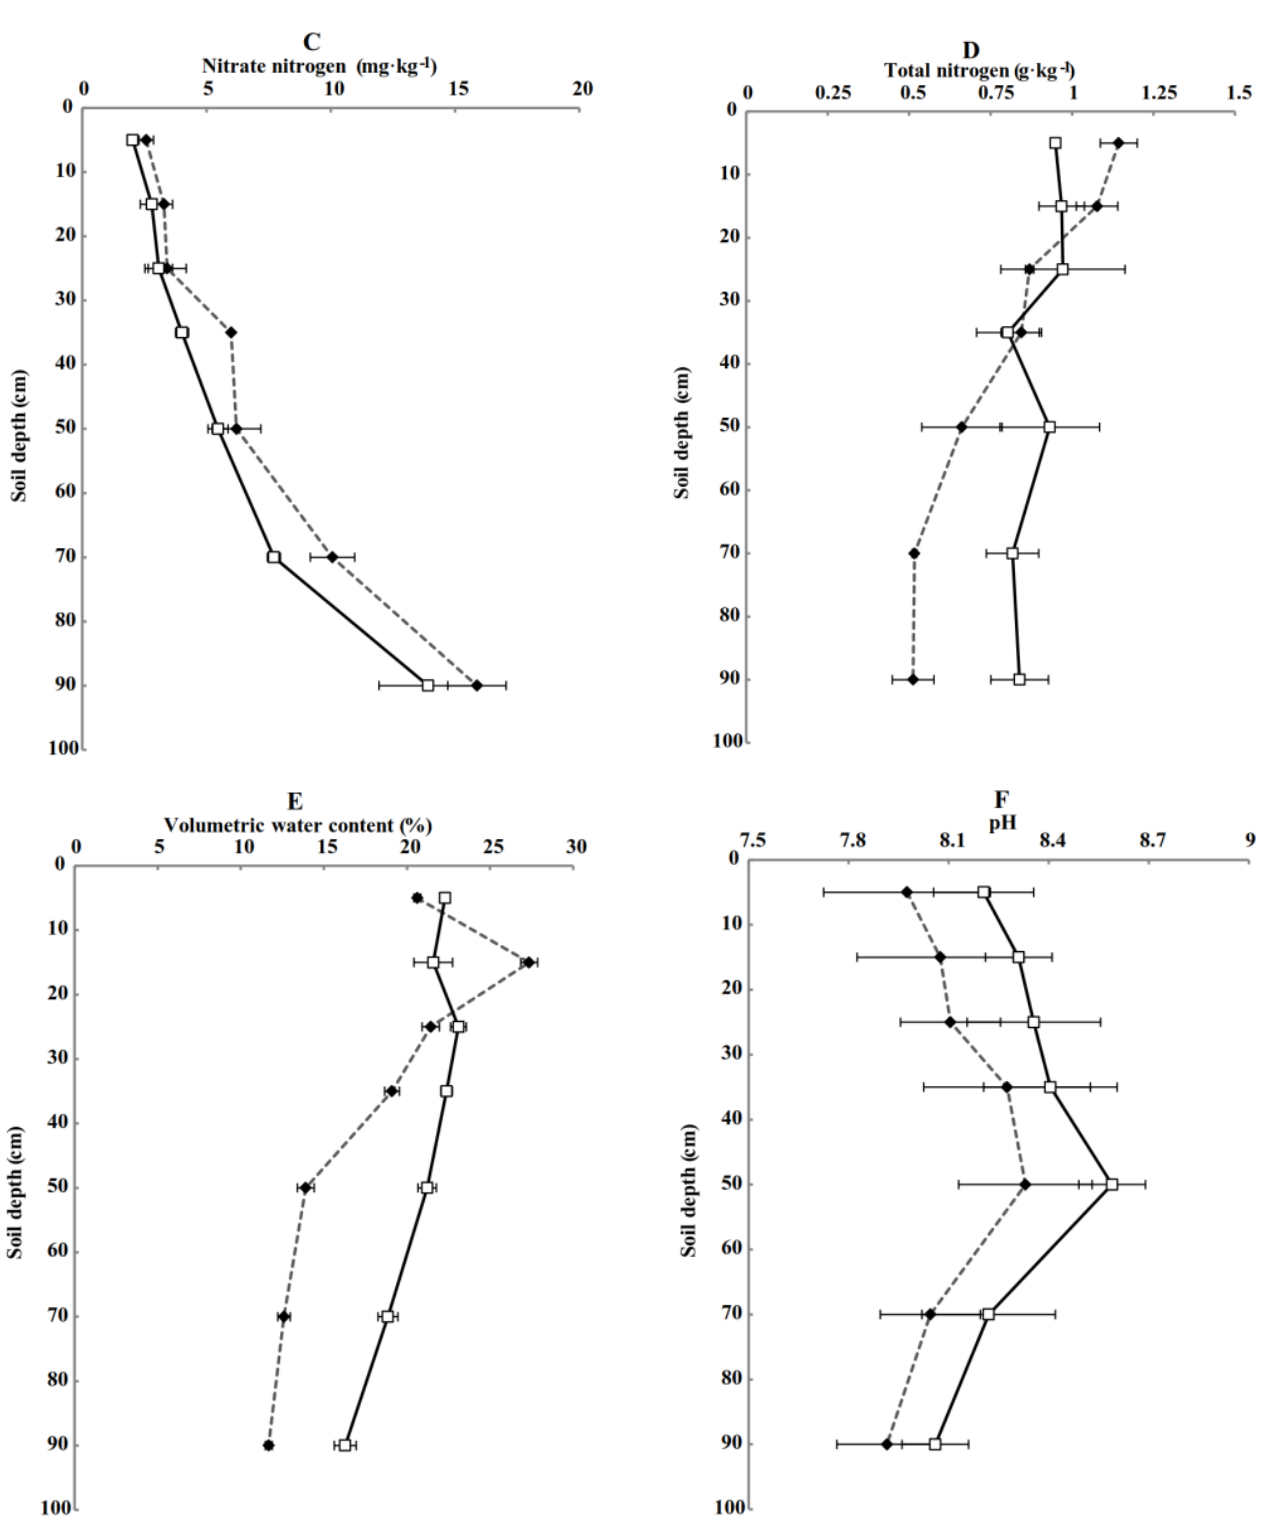
Figure 2. Effect of tillage methods on soil physicochemical property at 0–100 cm after harvest. ( A ) Total organic carbon; ( B ) Ammonium nitrogen; ( C ) Nitrate nitrogen; ( D ) Total nitrogen; ( E ) Volumetric water content; ( F ) pH. Data are means ±standard deviation ( n = 3).